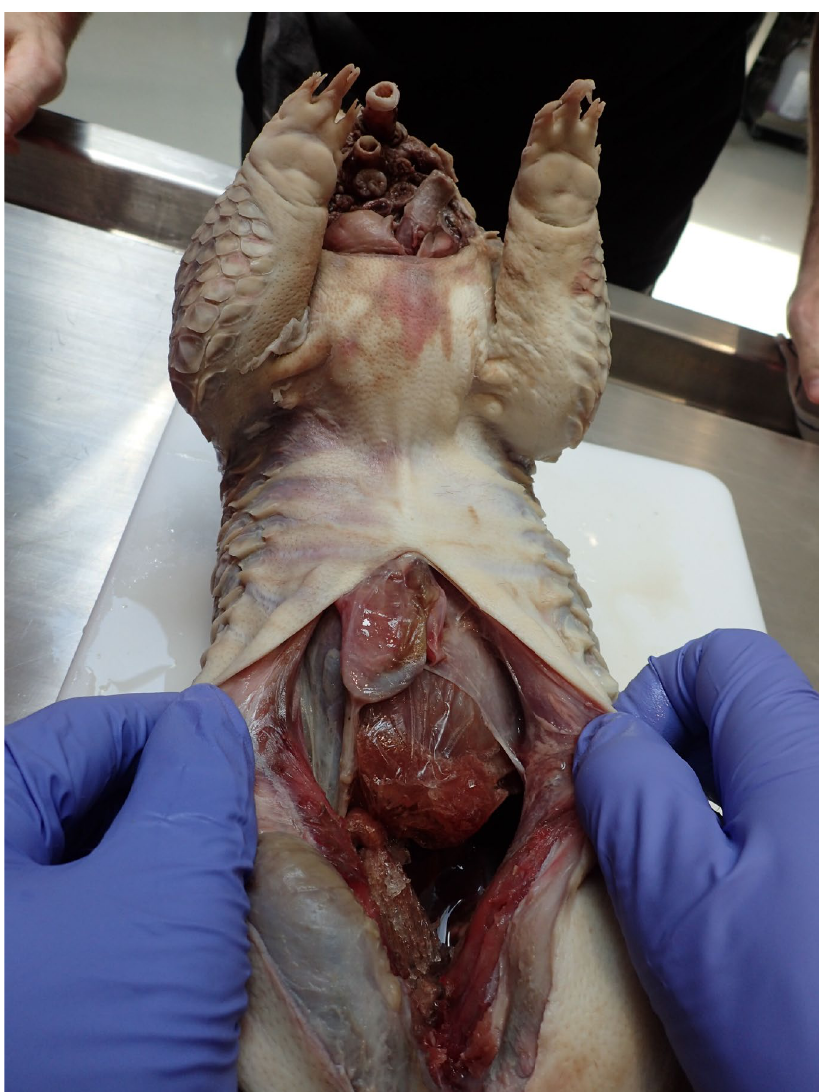
Figure 1. Carcass of pangolin, Manis javanica , at time of necropsy; note internal organs in bag in body cavity.